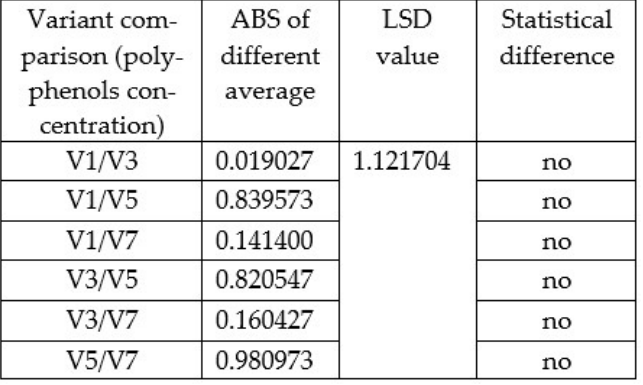
Figure 12. The statistical significance determined by LSD (Least Significant Difference) test values of polyphenols concentration in Lepidium sativum L. sprouts cultivated on gauze (V1 control, illuminated with sunlight; V3, illuminated with white LED; V5, illuminated with blue LED; and V7, illuminated with red LED experimental variant), t crit value = 2.306004.